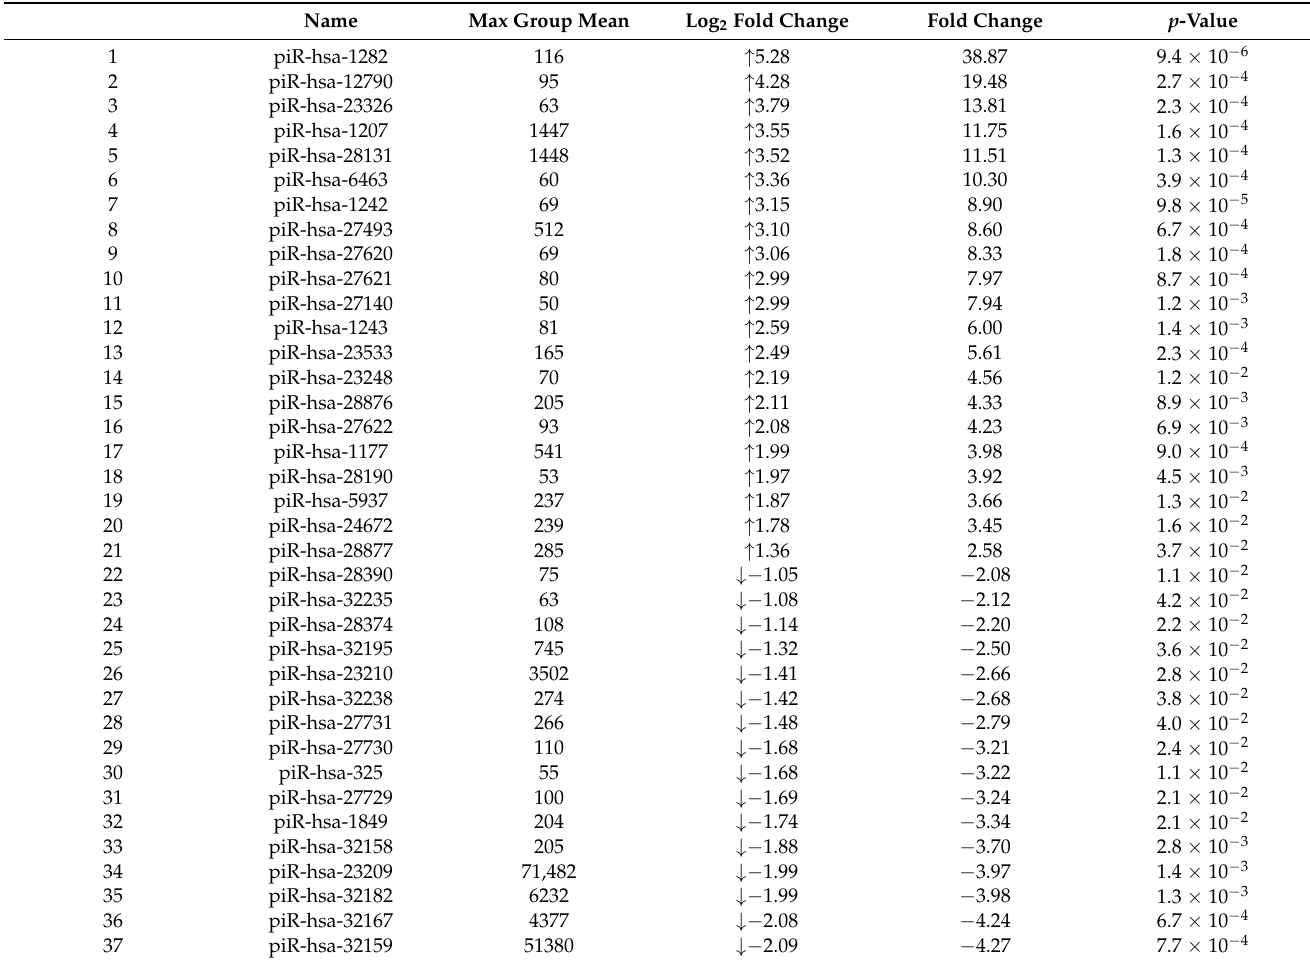
Table 5. Differentially expressed piRNAs between ASD vs. Control (Absolute fold change > 2; p < 0.05).